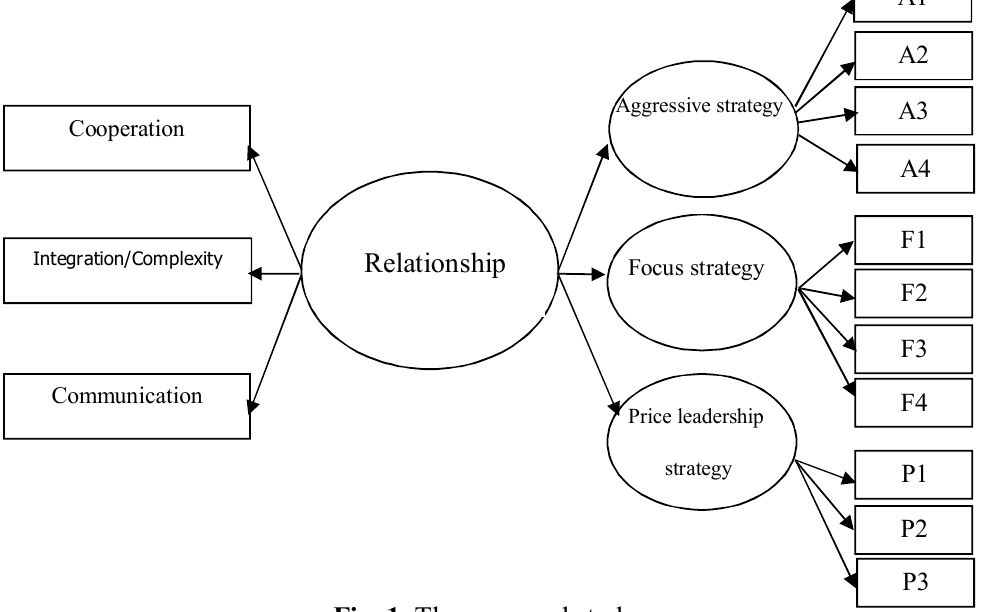
Fig. 1. The proposed